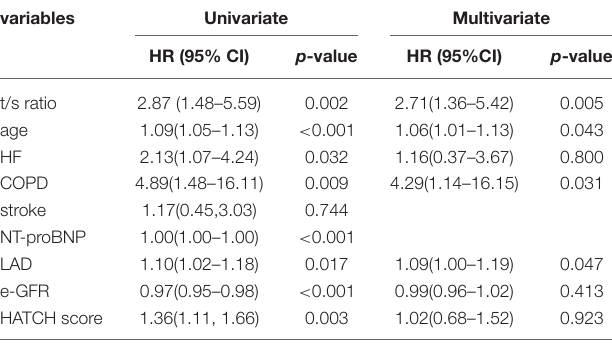
TABLE 3 | Cox regression analysis for progression of